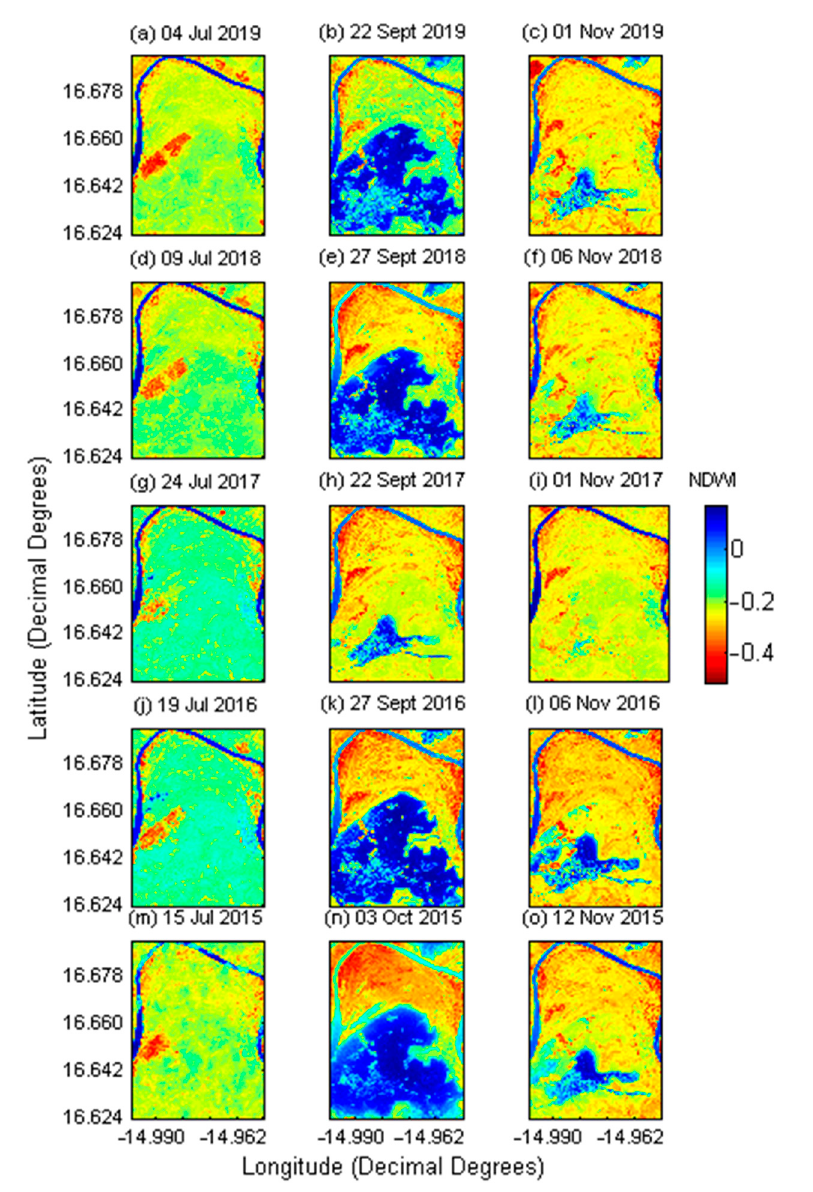
Figure 8. Flooding of the Podor basin based on NDWI on Sentinel-2A imagery (2015–2019). ( a – o ): left images show the period just before the flood, images in the middle are close to the maximum flood while images on right are at the end of the flood receding.